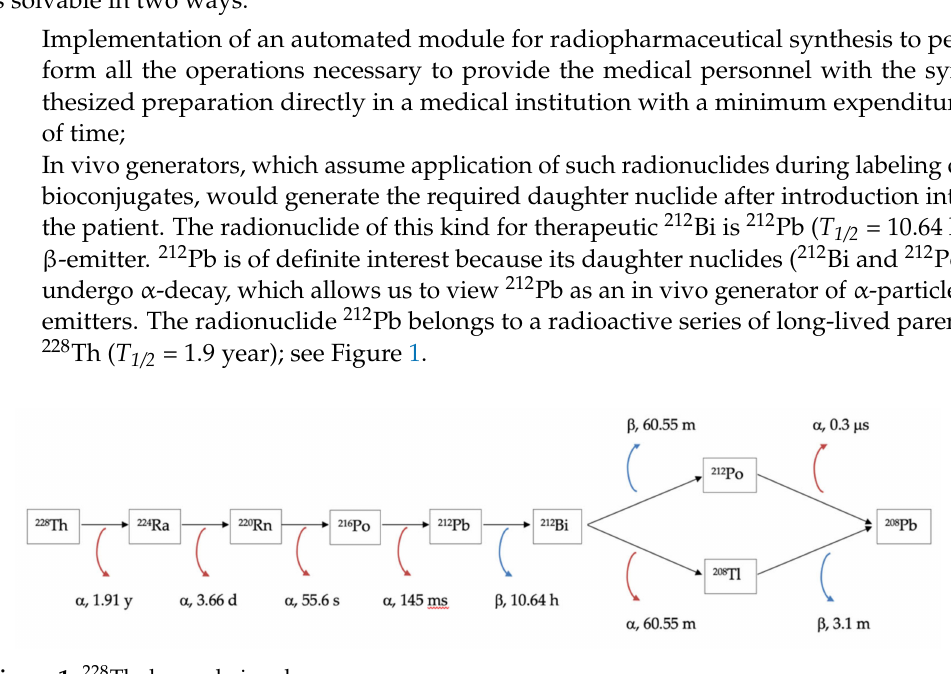
Figure 1. 228 Th decay chain